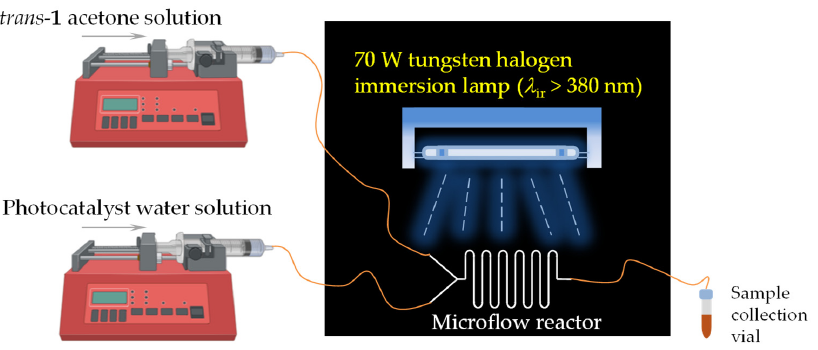
Figure 7. Experimental set-up for photocatalytic reactions performed in a microflow reactor.